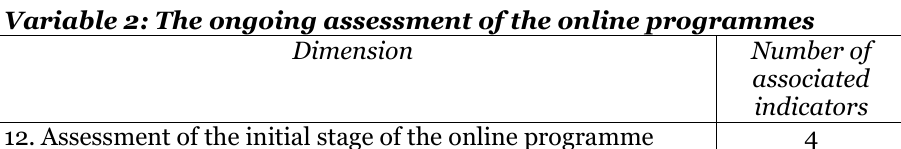
Variable 2: The ongoing assessment of the online